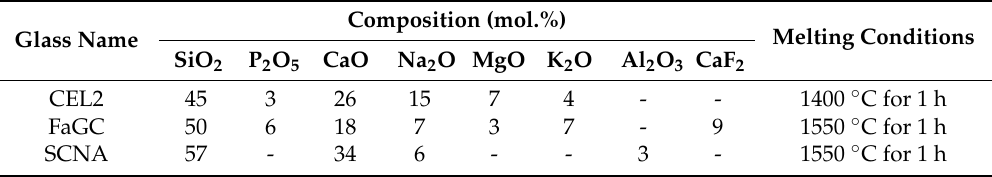
Table 1. Compositions and preparation details of the starting materials.